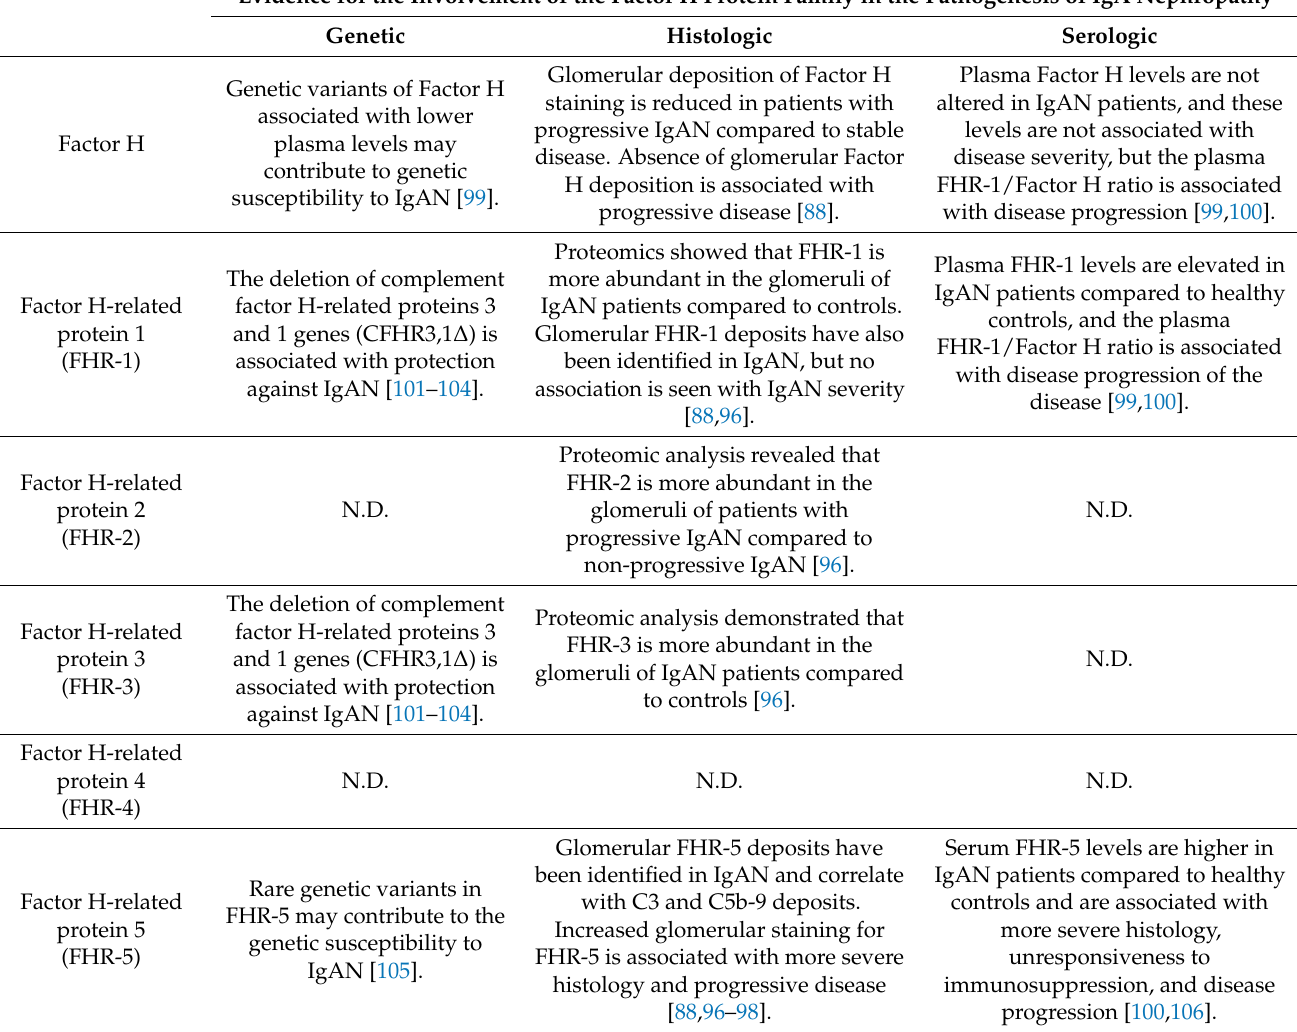
Table 1. The role of the Factor H protein family in IgA